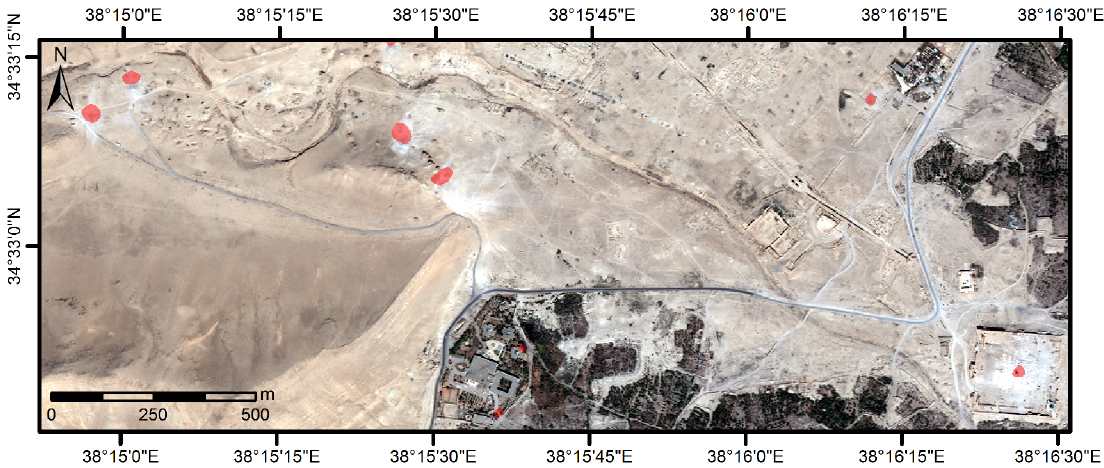
Figure 11. red: post-processed changes overlaid on the 2 September 2015 WorldView-2 image reported in Figure 5. All the main damaged areas are correctly identified with two small false alarms in the southern part of the image ( c (cid:13) European Space